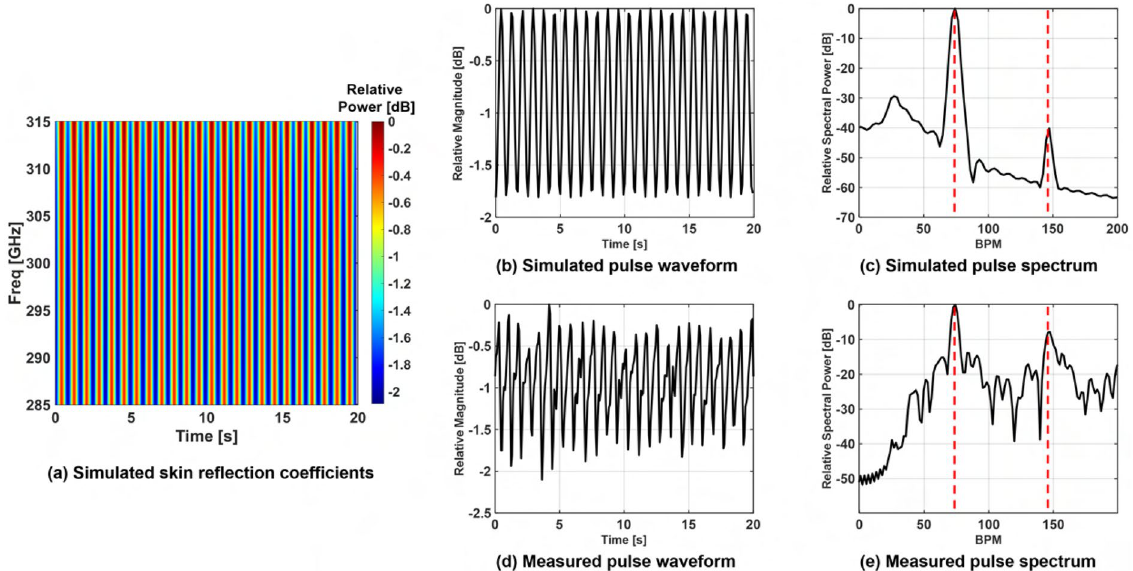
Figure 4. ( a ) The simulated skin reflection coefficients from time-varying dermis conductivity values due to cyclical blood flow (computer simulated at 72 cycles per minute) in the 285–315 GHz spectrum; ( b ) the corresponding pulse waveform extracted by averaging the simulated skin reflection coefficients across the frequency range; ( c ) the corresponding pulse frequency spectrum of the simulated data; ( d ) the reference THz pulse measurement in 285–315 GHz spectrum taken from a subject’s forehead; ( d ) the corresponding pulse frequency spectrum of the measured data. The peak-to-valley variation of the measurements ( d ) is similar to the one observed by the simulated data ( b ) approximately 1.8 dB and also the fundamental and second-order heartbeat harmonics locations are matched in the simulation data ( c ) and the measurement data ( e ), thus validating the working principle of the novel TPG measurement